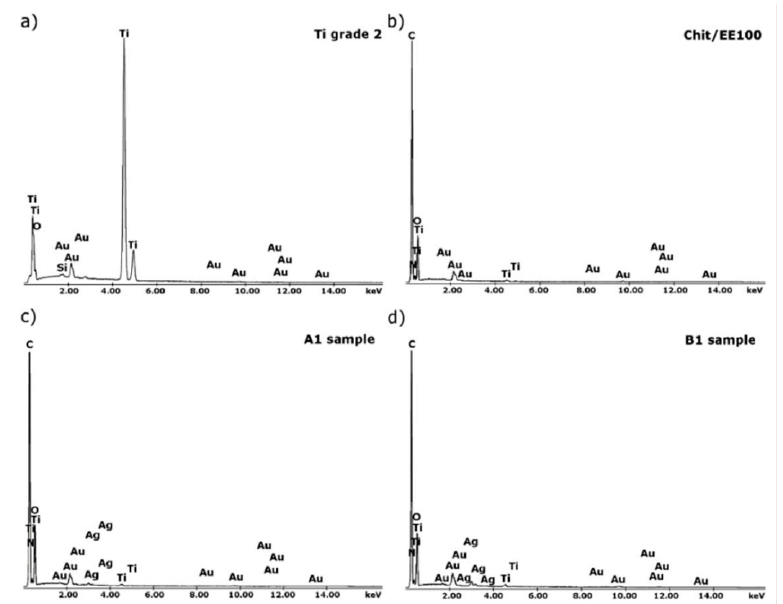
Figure 3. EDS spectra of ( a ) a bare titanium substrate; ( b ) the sample with the chit/EE100 coating and samples with chit/EE100/AgNPs coating: ( c ) A1 and ( d ) B1.